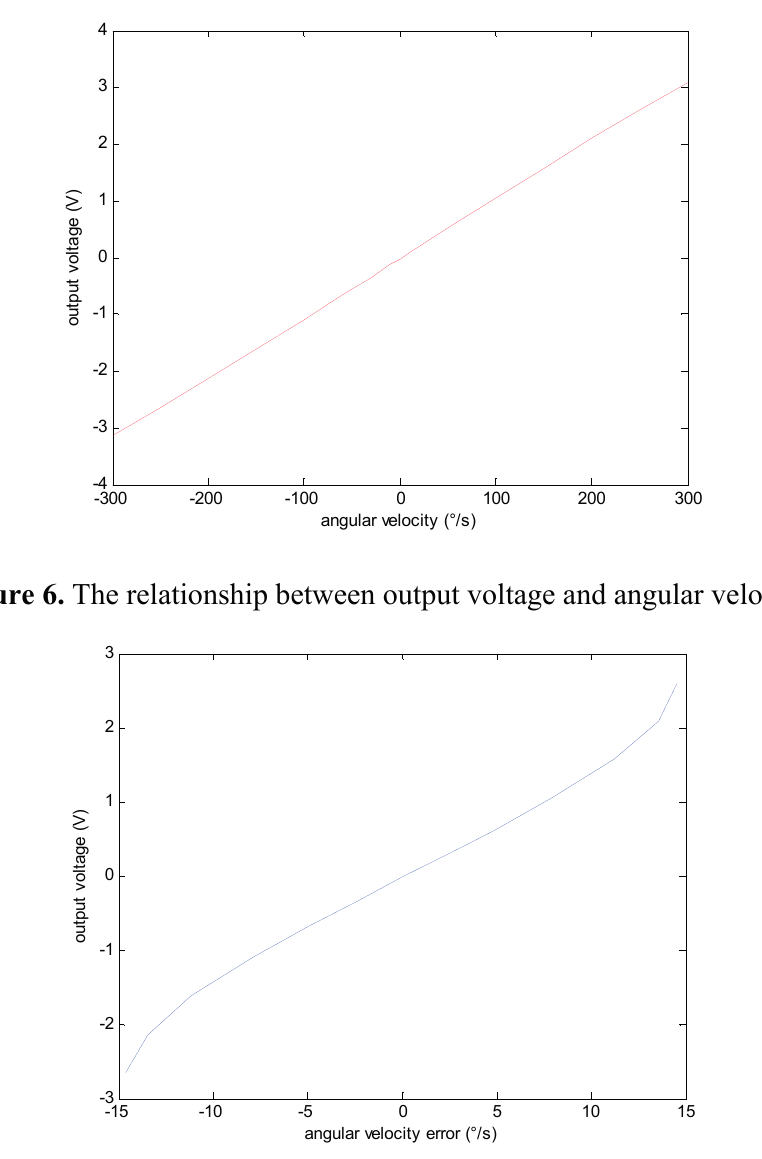
Figure 7. The relationship between output voltage and angular velocity